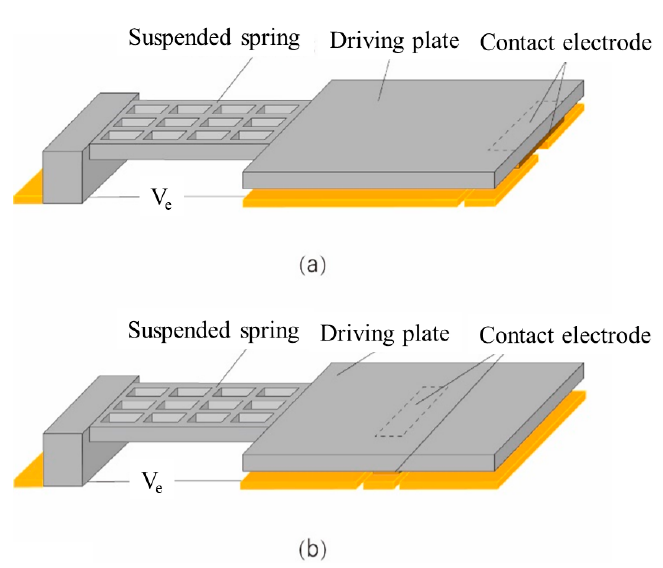
Figure 1. Schematic structure of the proposed micro-electro mechanical system (MEMS) relay for an individual element: ( a ) Contact electrode at the edge of the cantilever relay; ( b ) cantilever relay with an embedded contact